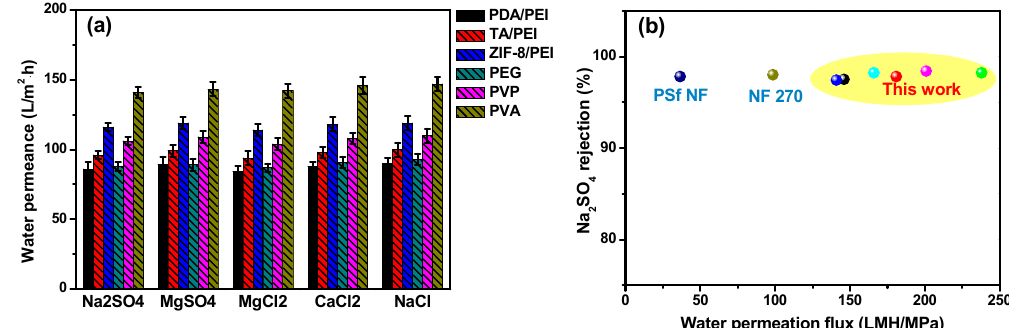
Figure 5. ( a ) Water permeation of the as-prepared NF membranes with the hydrophilic modified interlayers on the PSf substrates or the addition of macromolecular additives in the aqueous PIP solution (test conditions: inorganic salts concentration = 1000 mg/L, pH = 6.5, 25 °C, applied pressure = 0.6 MPa and cross-flow rate = 30 L/h); ( b ) the comparison of the NF performance with other NF membranes in the reported literature [30,39].